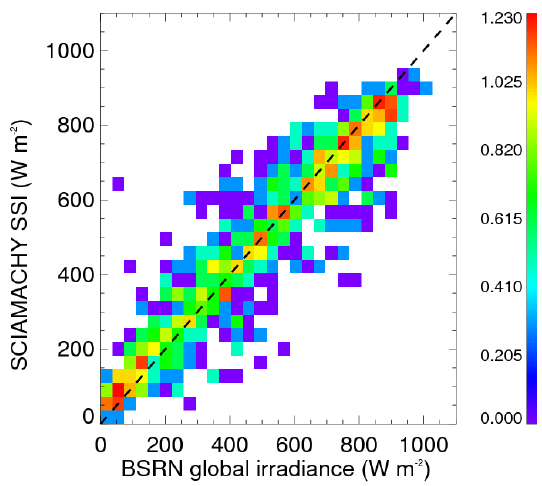
Figure 7. Scatter density plot of the instantaneous SCIAMACHY surface solar irradiance (SSI) versus the hourly mean BSRN global irradiances for all the collocated data in 2008. The dashed line is the one-to-one line. The color scale indicates the logarithm of the number density of the data points.